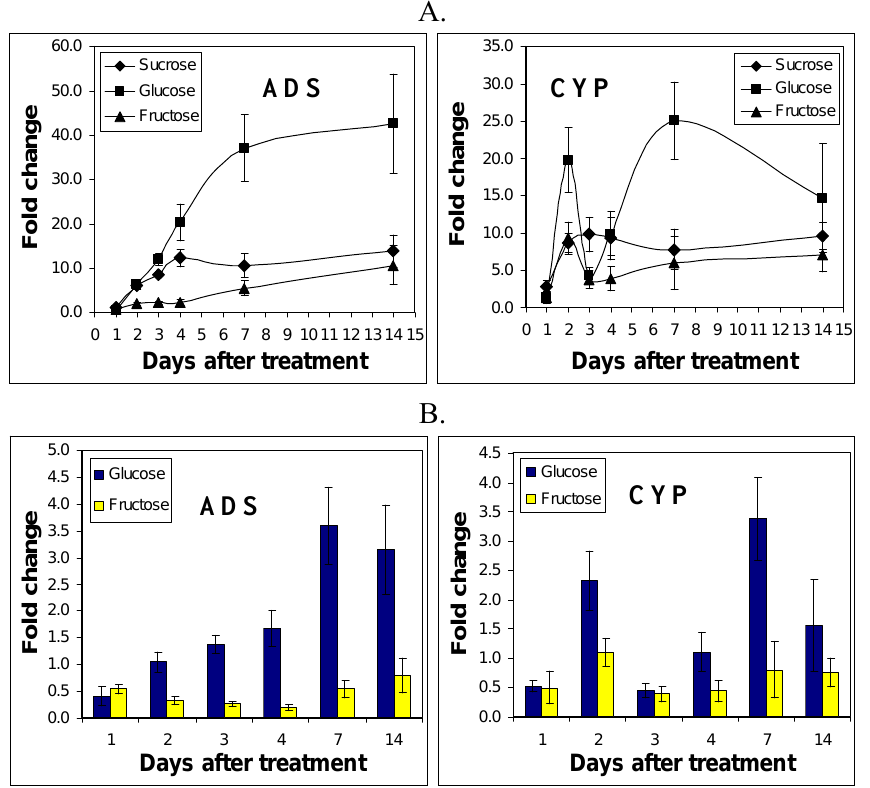
Figure 4. (A) Changes in ADS and CYP in A. annua seedlings grown 14 days in glucose, fructose, or sucrose relative to day zero. (B) Relative response of ADS and CYP in A. annua seedlings grown in glucose or fructose and compared to growth in sucrose. Bars are ± SD.